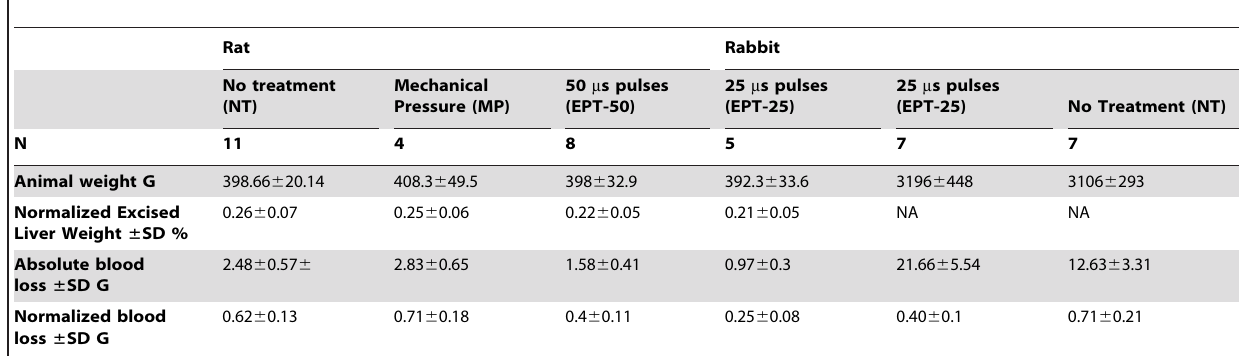
Table 1. Animal weight, excised liver weight, absolute and normalized blood loss in all animal treatment groups.